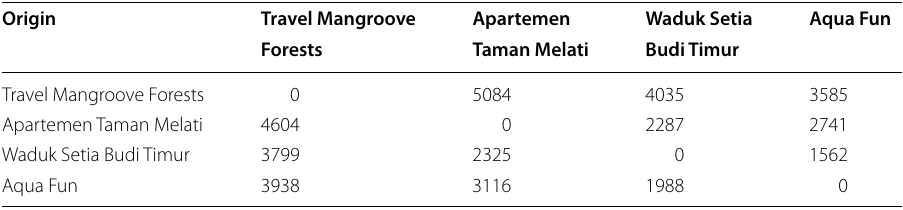
Table 3 Sample of duration matrix (in seconds) Origin Travel Mangroove